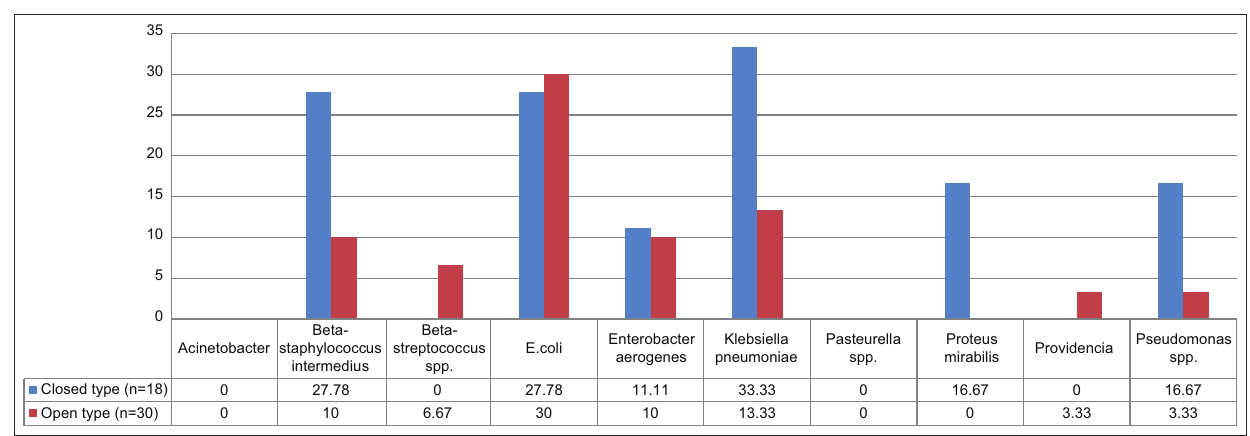
Figure-2: Percentage by bacterial species from aerobic bacterial culture from uterine content of closed (n = 18) and open (n = 30) pyometra